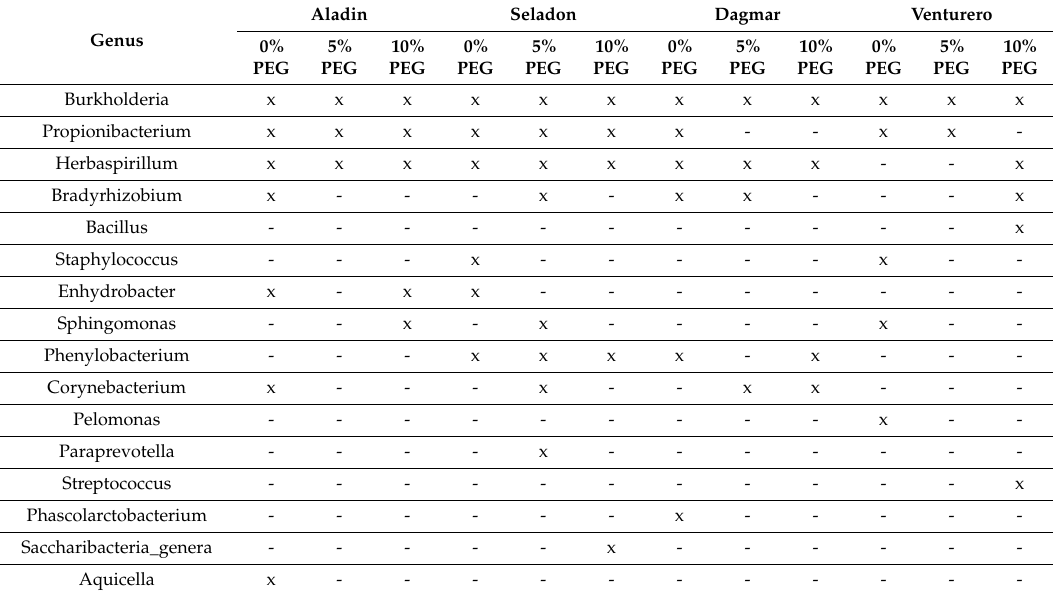
Table 4. Distribution of identified bacterial genera in the individually analyzed wheat varieties. Aladin Seladon Dagmar Venturero Genus 0% 5% 10% 0% 5% 10% 0% 5% 10% 0% 5% 10% PEG PEG PEG PEG PEG PEG PEG PEG PEG PEG PEG PEG Burkholderia x x x x x x x x x x x x Propionibacterium x x x x x x x - - x x - Herbaspirillum x x x x x x x x x - - x Bradyrhizobium x - - - x - x x - - - x Bacillus - - - - - - - - - - - x Staphylococcus - - - x - - - - - x - - Enhydrobacter x - x x - - - - - - - - Sphingomonas - - x - x - - - - x - - Phenylobacterium - - - x x x x - x - - - Corynebacterium x - - - x - - x x - - - Pelomonas - - - - - - - - - x - - Paraprevotella - - - - x - - - - - - - Streptococcus - - - - - - - - - - - x Phascolarctobacterium - - - - - - x - -